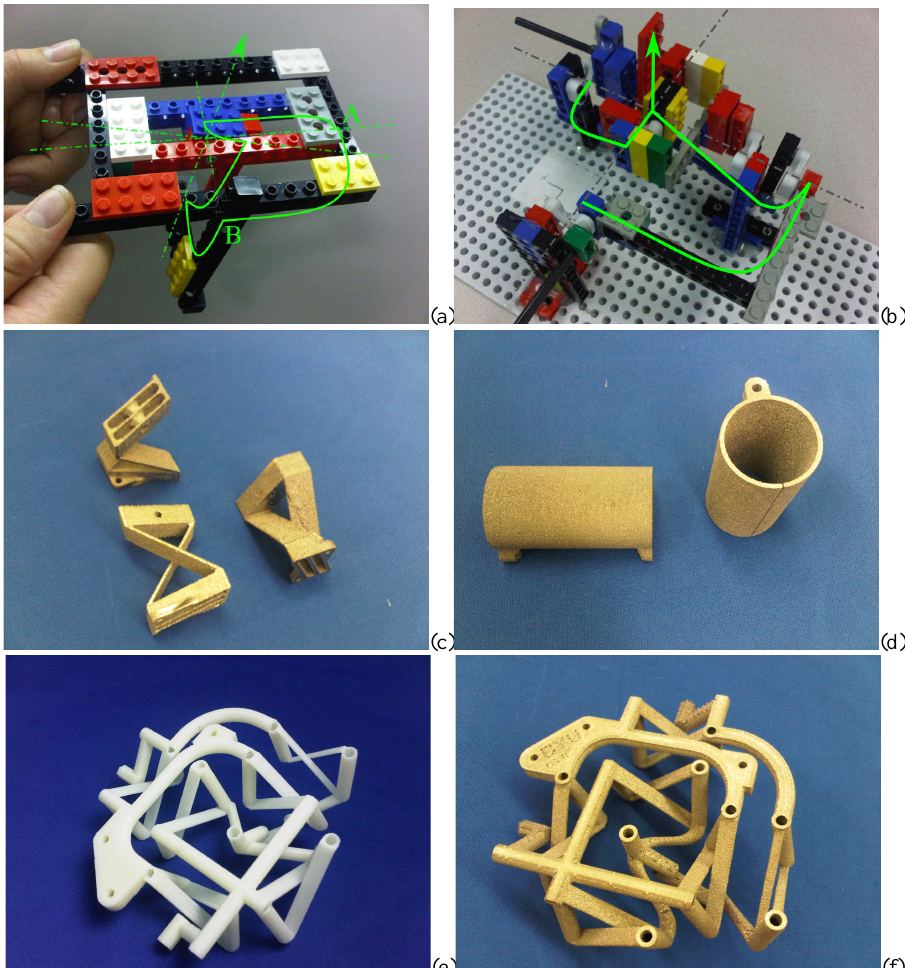
Figure 7. Titanium prototype. (a) Spherical 5-bar with central pointing platform. Rotations at A and B give two DOF. (b) Compliant prototype to confirm rigid concept. (c) Titanium CAFPs. (d) Titanium STFs. (e) Monolithic ABS prototype. (f) Titanium